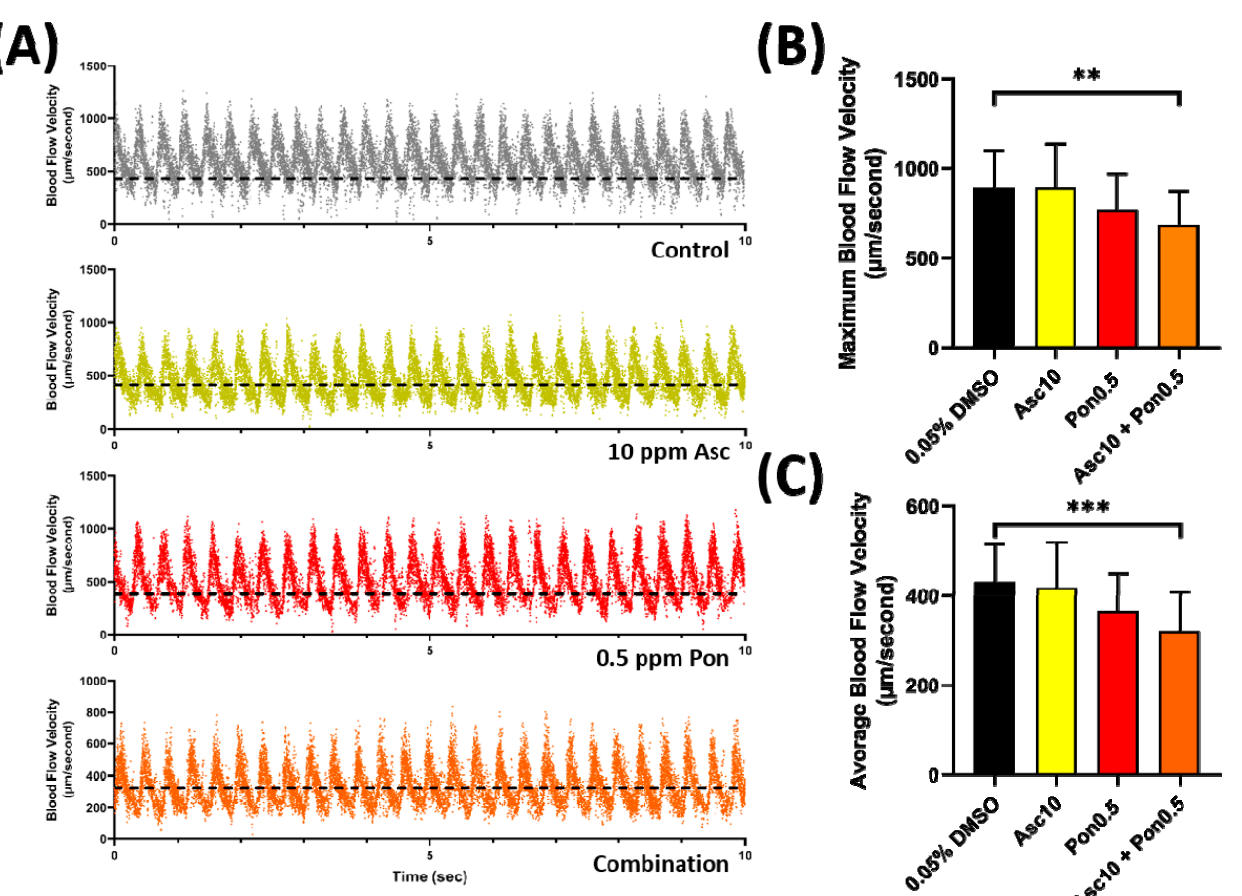
Figure 6. Representative zebrafish larvae blood flow oscillation pattern after incubation in 0.05% DMSO (grey), 10 ppm of ASC (yellow), 0.5 ppm of PON (red), and a combination of both compound (orange) (dash line show the average velocity) ( A ). Maximum ( B ) and average ( C ) blood flow velocity in the dorsal aorta of zebrafish larvae after exposure to ASC and PON. Data are presented as mean ± standard deviation, and the statistical significance was calculated using ordinary one-way ANOVA with Dunnet multiple comparison test. (** p < 0.01, *** p < 0.001).